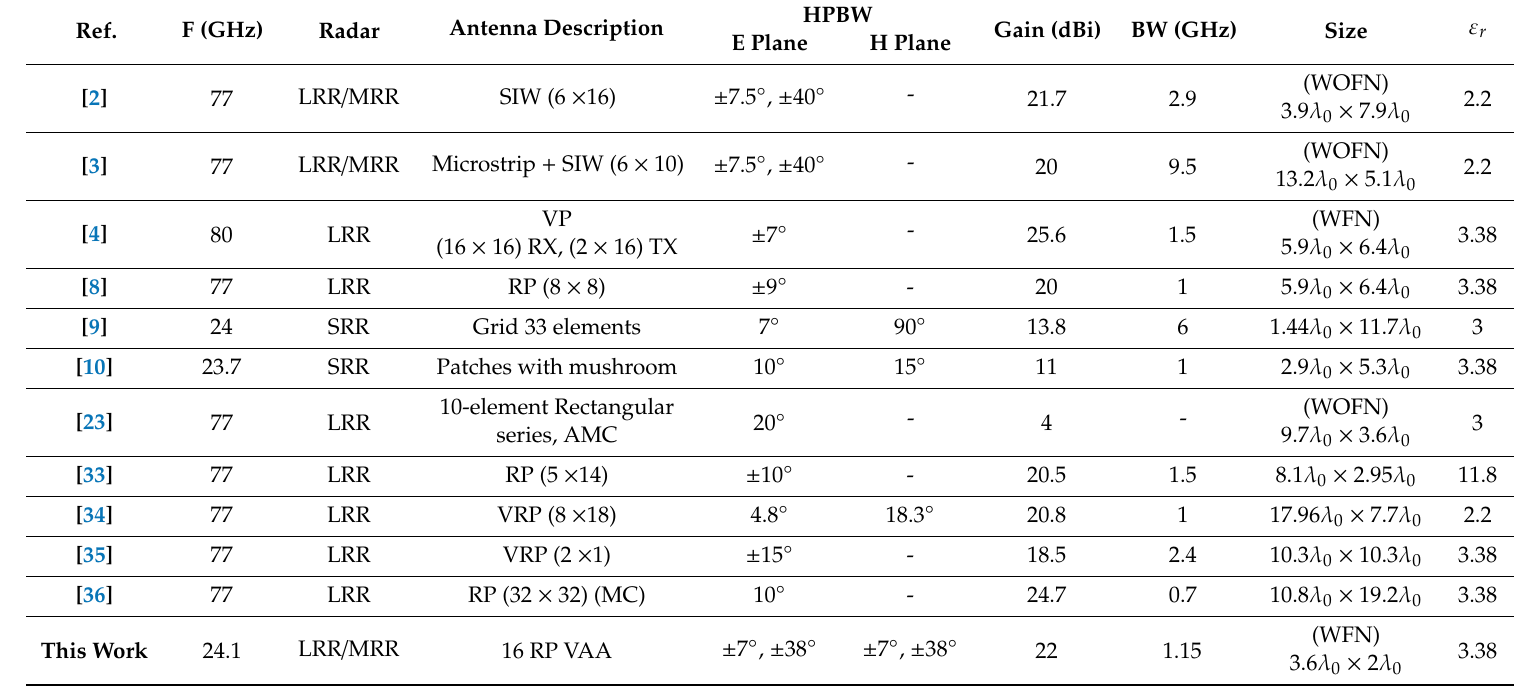
Table 3. Comparison between proposed antenna and antennas in